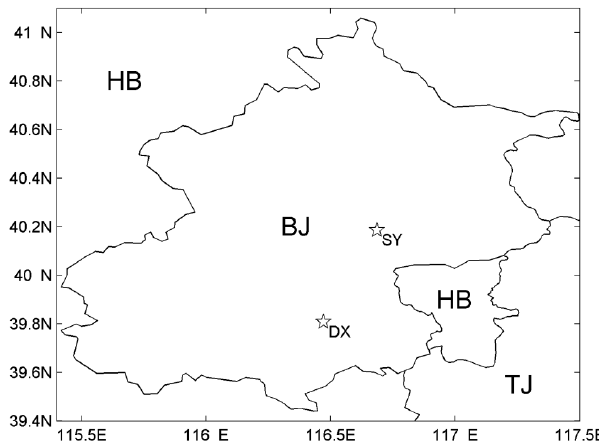
Figure 2. The locations of the X-band radar and the S-band radar,the X-band radar is at Shunyi (SY, 116.68° E, 40.19° N), the S-band radar is at Daxing (DX, 116.47° E, 39.81° N). The symbols BJ, HB and TJ in the Figure are the abbreviation of Beijing City, Hebei Province and Tianjin City, respectively.